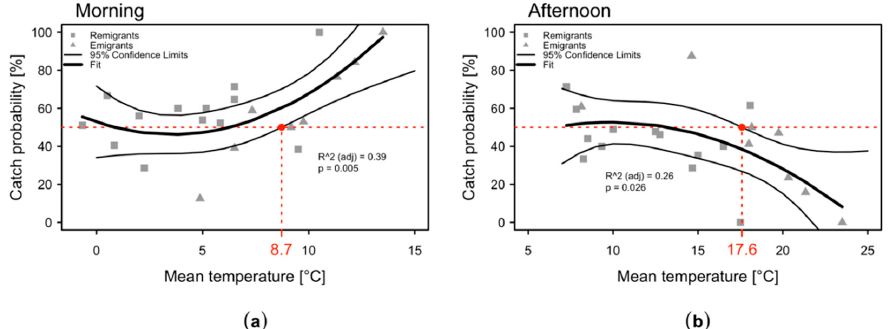
Figure 3. Probability of catching C. melanoneura specimens depending on the temperature ( a ) in the morning (7–9 am); ( b ) in the afternoon (2–4 pm). Analysis was conducted to establish whether the probability of catching more C. melanoneura individuals is dependent on the temperature in the morning or in the afternoon. The 50% threshold ( y -axis) indicates equal catch probabilities between morning and afternoon. If the temperature was above 8.7 ◦ C in the morning, the catch probability was higher ( > 50%) in the morning ( a ). If the temperature in the afternoon was below 17.6 ◦ C, the catch probability was similar in the morning and in the afternoon, respectively ( b